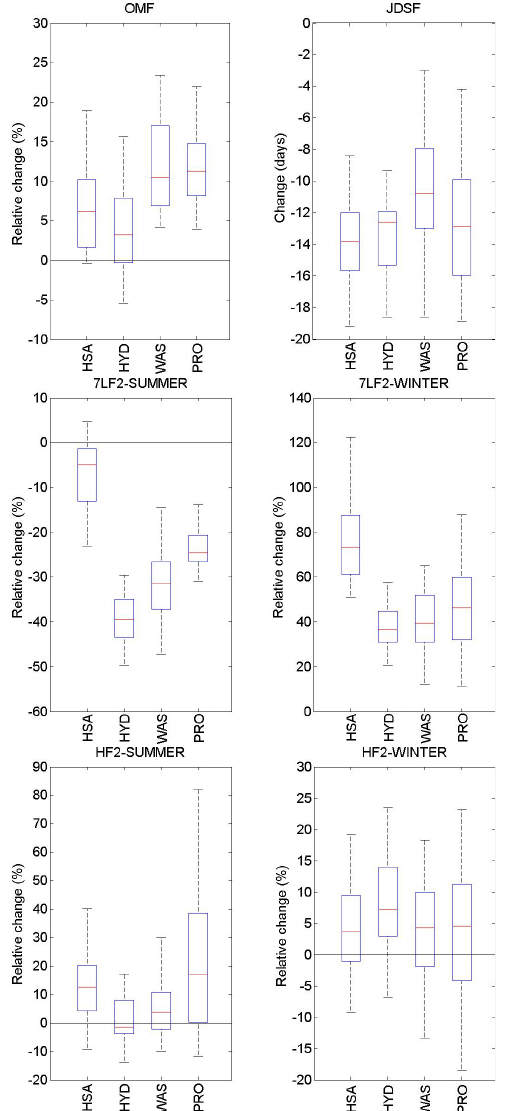
Fig. 8. Same as Fig. 7 but for Schlehdorf